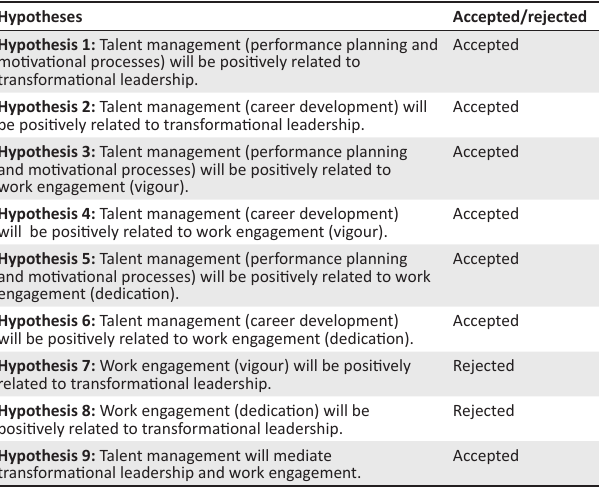
TABLE 4: Hypotheses